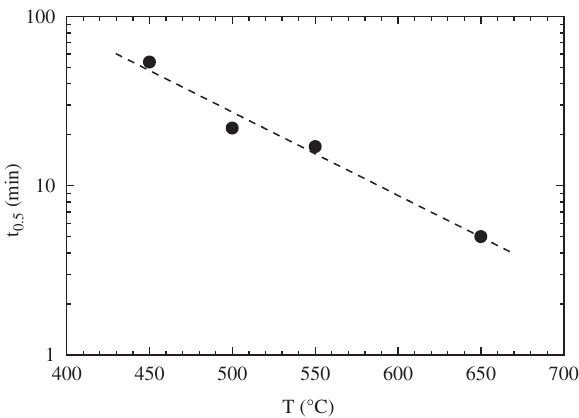
Figure 6. Time for 50% transformation (t temperature.